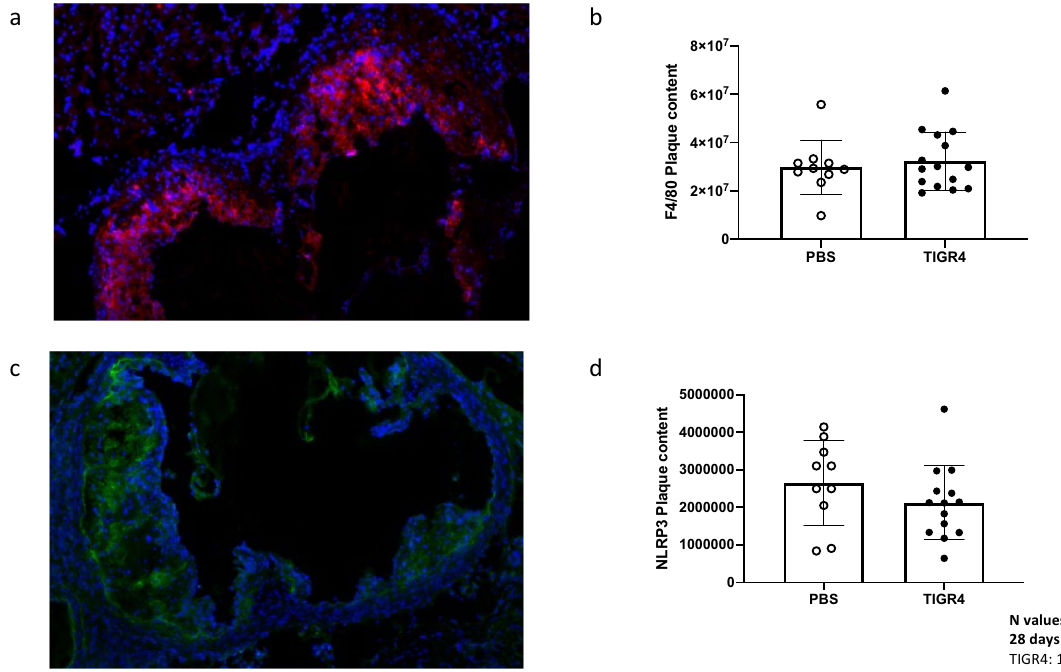
Figure 3. Immunofluorescence staining of aortic root. ( a ) A representative image (taken at 10x) of aortic root stained for F4/80 (red) and DAPI (blue) from TIGR4- and PBS- inoculated mice at 28-days post-inoculation. ( b ) Red fluorescence intensity was quantified per area in plaque regions (minus any background fluorescence detected) and compared between groups. ( c ) Representative image (taken at 10x) of aortic root stained for NLRP3 (green) and DAPI (blue) from TIGR4- and PBS- inoculated mice at 28-days post-inoculation. ( d ) Green fluorescence intensity was quantified per area in plaque regions (minus any background fluorescence detected) and compared between groups. No significance was